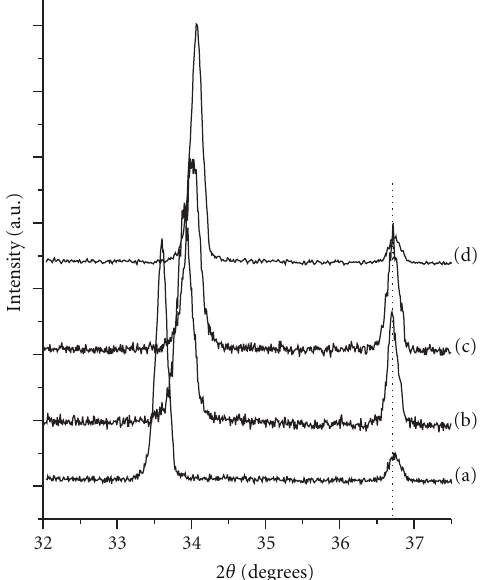
Figure 4: (110) XRD peak of perovskite-like structure used to calculate the cell parameters of (a) LaAlO 3 , (b) La 0 . 3 Eu 0 . 7 AlO 3 , (c) La 0 . 1 Eu 0 . 9 AlO 3 , and (d) EuAlO 3 . As standard, the peak of quartz was used (marked with the dotted line).